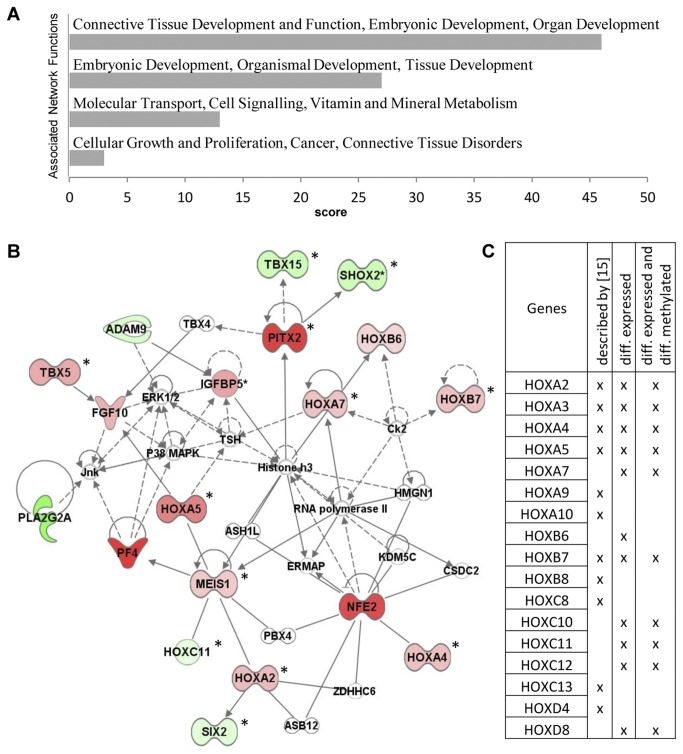
Pathway analysis of differentially expressed genes in abdominal fat samples compared to gluteal fat samples.A Top associated networks for differentially expressed genes in abdominal cells derived from IPA (Ingenuity pathway analysis). B Top network built by differentially expressed genes in abdominal fat cells compared to gluteal fat cells. Red color indicates upregulated genes in abdominal cells, green color downregulated genes in abdominal cells. Genes marked with asterisks showed differential methylation between both depots. ADAM9, ADAM metallopeptidase domain 9; FGF10, fibroblast growth factor 10; HOXA2, homeobox A2; HOXA4, homeobox A4; HOXA5, homeobox A5; HOXA7, homeobox A7; HOXB6, homeobox B6; HOXB7, homeobox B7; HOXC11, homeobox C11; IGFBP5, insulin-like growth factor binding protein 5; MEIS1, Meis homeobox 1; NFE2, nuclear factor (erythroid-derived 2); PF4, platelet factor 4; PITX2, paired-like homeodomain; PLA2G2A, phospholipase A2, group IIA; SHOX2, short stature homeobox 2; SIX2, SIX homeobox 2; TBX5, T-box 5; TBX15, T-box 15. C Comparative illustration of HOX genes that (1) have been previously described as differentially expressed in gluteal and abdominal depots [14], (2) HOX genes, that were found to be differentially expressed in our study and (3) HOX genes that showed differential expression and differential methylation in our study.